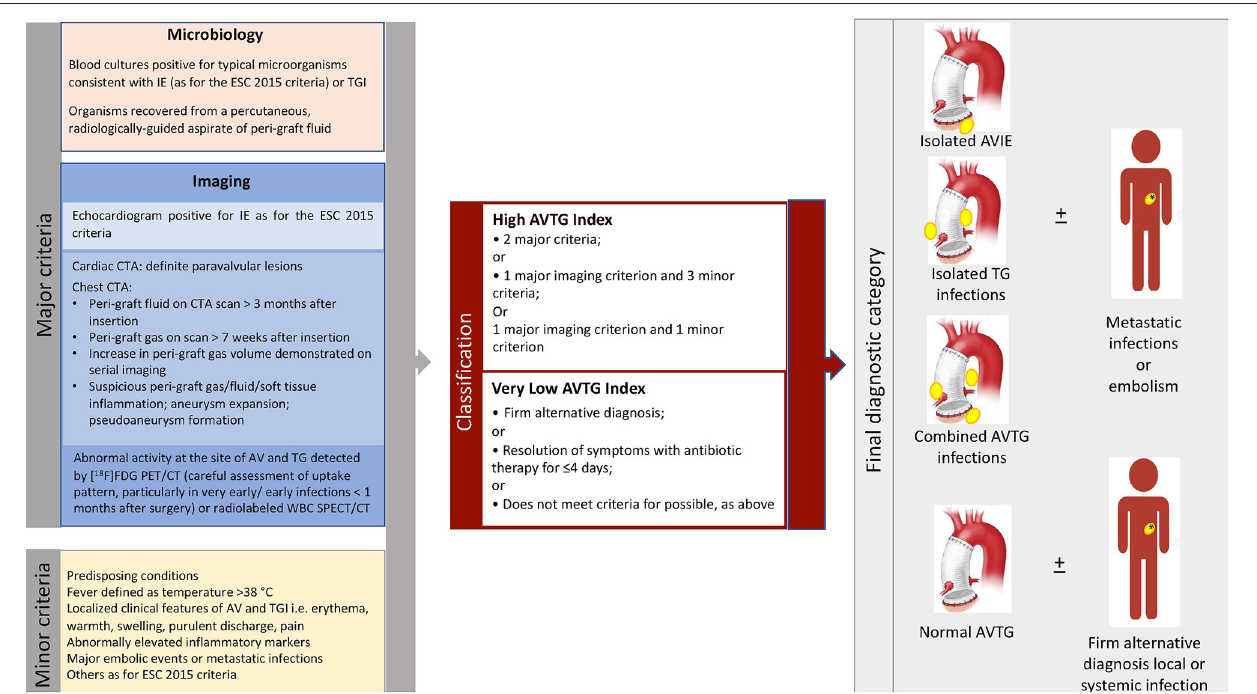
FIGURE 1 | Summary of the major and minor criteria for the diagnosis of aortic valve and aortic tube graft infection proposed (aortic valve tube graft criteria, left panel), interpretation (middle panel), and final classification of patients based on their application (right panel). AVTG, aortic valve tube graft; CTA, CT angiography;